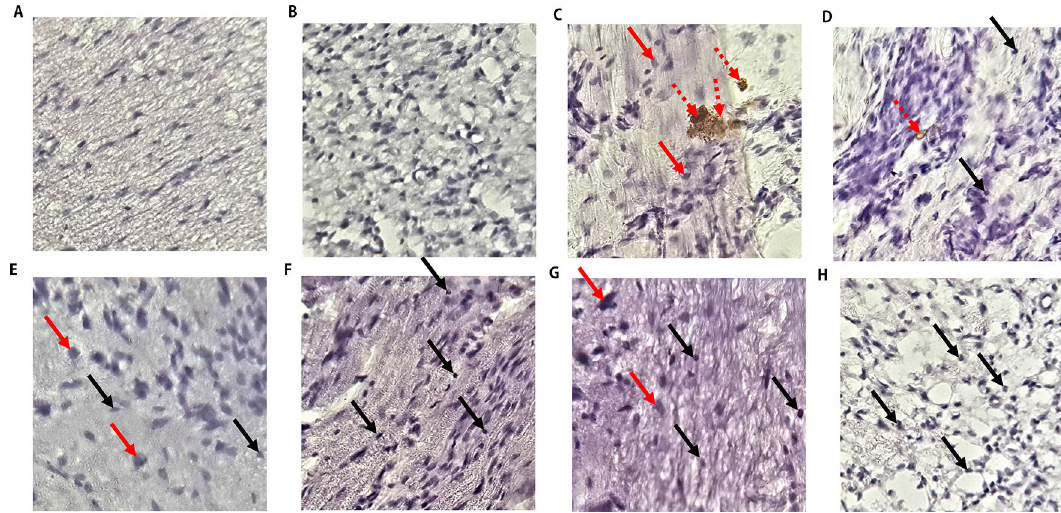
Figure 9. Bromelain improved neuronal myelination and down-regulated the expression of inducible nitric oxide synthase (iNOS) in the sciatic nerve. Bromelain attenuated the swelling and degeneration of myelinated neurons. It increased the myelination of neurons and mitigated the expression of iNOS. Red arrows indicate swelling of the myelinated neurons; black arrows indicate normal and non-swollen myelinated neurons, broken red arrows indicate expression of iNOS. ( A ) Unligated control ( B ) Sham control ( C ) Ligated control ( D ) Reference control (30 mg/kg gabapentin) ( E ) Low dose bromelain (30 mg/kg) ( F ) High dose bromelain (50 mg/ kg) ( G ) Pre-treated low dose bromelain (30 mg/kg) ( H ) Pre-treated high dose